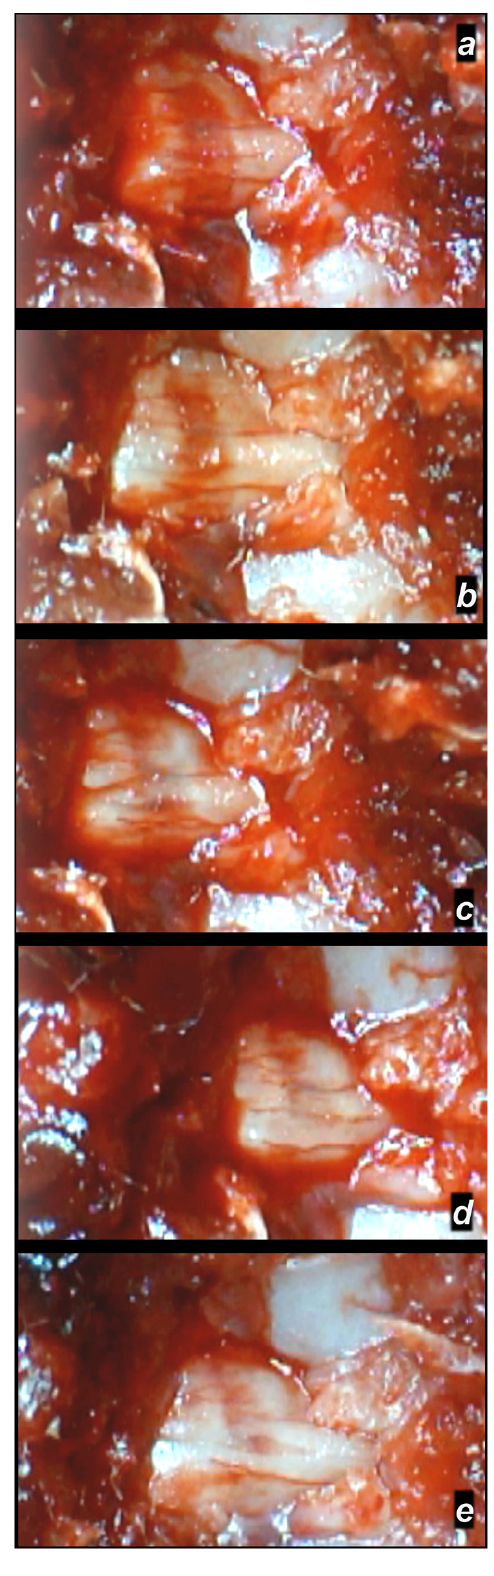
Figure 6. Spinal cord hematoma presentation following spinal cord compression (for 1 min) (a camera attached to a VMS-004 Discovery Deluxe USB microscope (Veho, Denver, CO, USA)). Presentation at 10 min following injury ( a ), before therapy, ( a ); and, ( b – e ) after BPC 157 application (10 μ g/kg ip), immediately ( b ), at 5 min ( c ), at 10 min ( d ), and at 20 min ( e ). Delayed Post-Injury Course, Immediate Effect (ii). Control. At day 4 post-injury, the advanced course of the spinal cord swelling and hematoma (Figure 7a) could be not prevented by the saline intragastric application as far could be seen during the 20 min post-therapy period (Figure 7b–e).